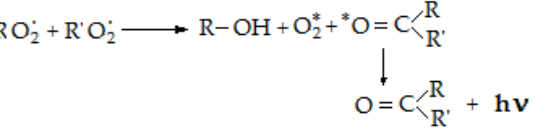
Figure 2. The principle scheme for the chemiluminescence emission in oxidizing polymers .